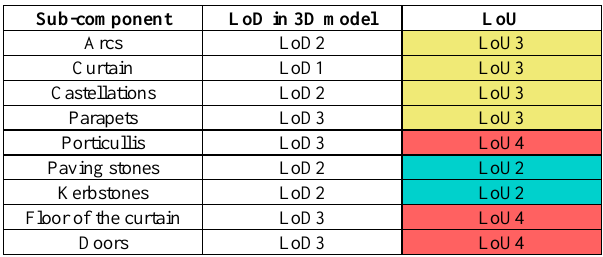
Table 3. Links between LoDs and LoUs for sub-components of the double